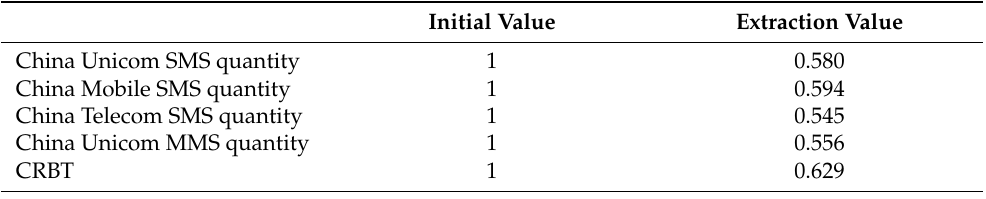
Table 14. Common factor variance—adapted from Zhang [6].